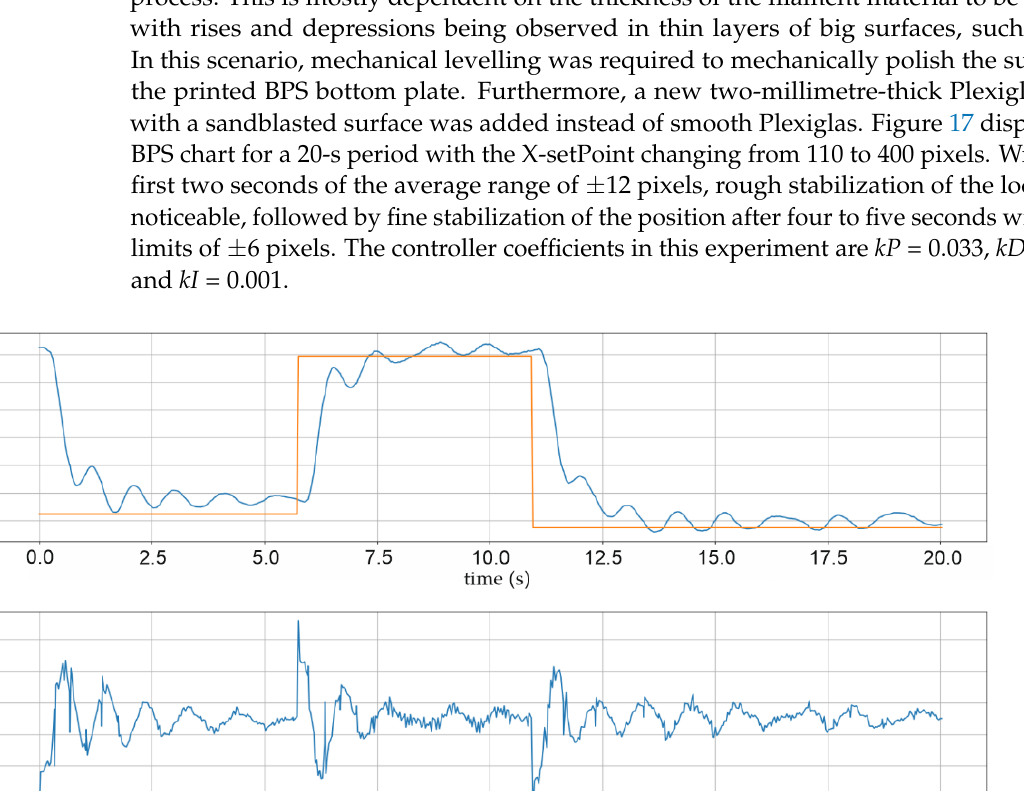
( d ) Figure 18. Examples of “light shadow error” . This makes it difficult to use the Python method “inRange ()” as previously de- scribed. As indicated in the advanced block diagram in Figure 14, it was important to describe and document these sensor feedback defects caused by a poor image conversion system, which is referred to as “ light shadow error ” or d 2 ( t ) dysfunction. Several smaller discrete shaded light sources were added to mitigate this negative effect, and the control precision was greatly enhanced. This increased the amount of light directed towards the ball, which at the time had no visible shadow. A resolution issue, known as “ particular distance mistake ” , was also discovered. It is the control system ’ s failure to recognize a new sphere centre position setPoint that is very close to the existing actual setPoint. This could be classified as a sort of hysteresis, i.e., sensor or computer vision recognition insensitivity. The largest specified distance error was found to be 6-pixels or roughly two millime- tres. This is the same as the diameter of the red dot that represents the sphere ’ s center of mass. The control instruction to move the ball 4 pixels in the horizontal X -axis direction is shown in Figure 19, however, there is no answer since the needed setPoint offset is within the defined distance error, which is the size of the sensor recognition error. Figure 1 9’ s time graph on the right side displays the setPoint value of the ball at “201 pixels” on the panel and no actual signal from the controller. The blue line represents the signal noise